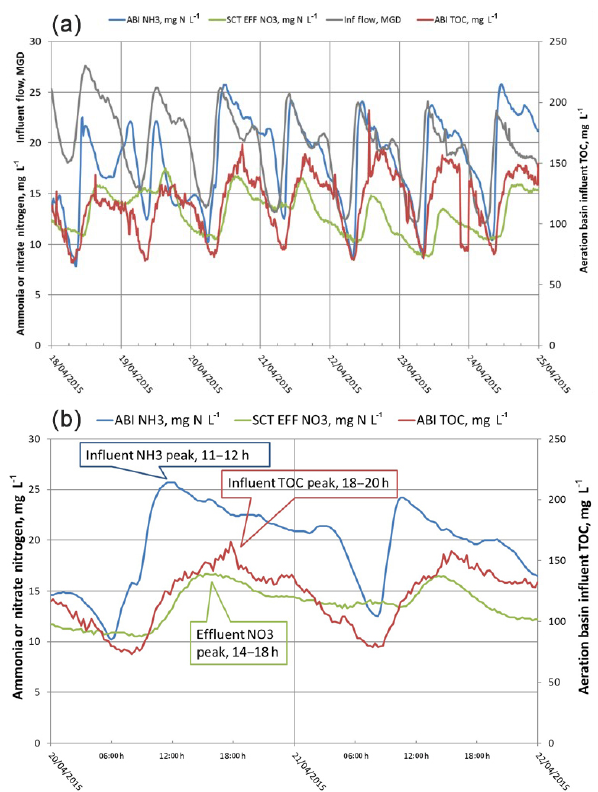
Figure 1. (a) Weekly diurnal patterns of ammonia and TOC at the aeration basin influent (ABI) and of nitrate at the secondary clarifier influent (SCT Eff). (b) Daily diurnal patterns of ammonia and TOC at the ABI and of nitrate at the secondary clarifier influ- ent (SCT